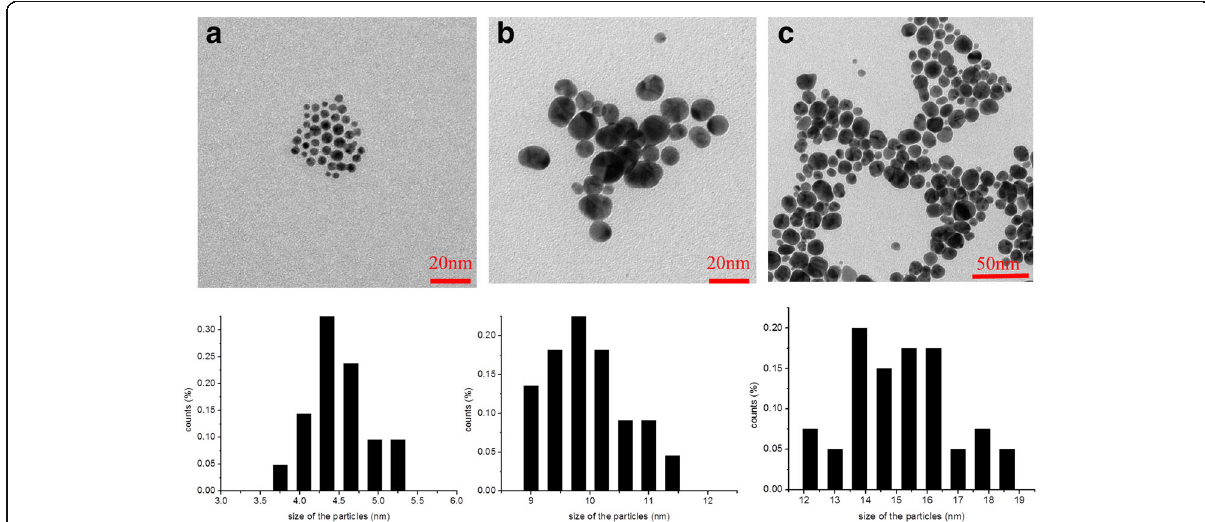
Fig. 5 TEM image and size distribution of Au@DSHPG. a Au@DSHPG-1 (HPG (cid:1) M n = 1123), b Au@DSHPG-2 (HPG (cid:1) M n = 3826), and c Au@DSHPG-3 (HPG (cid:1) M n =